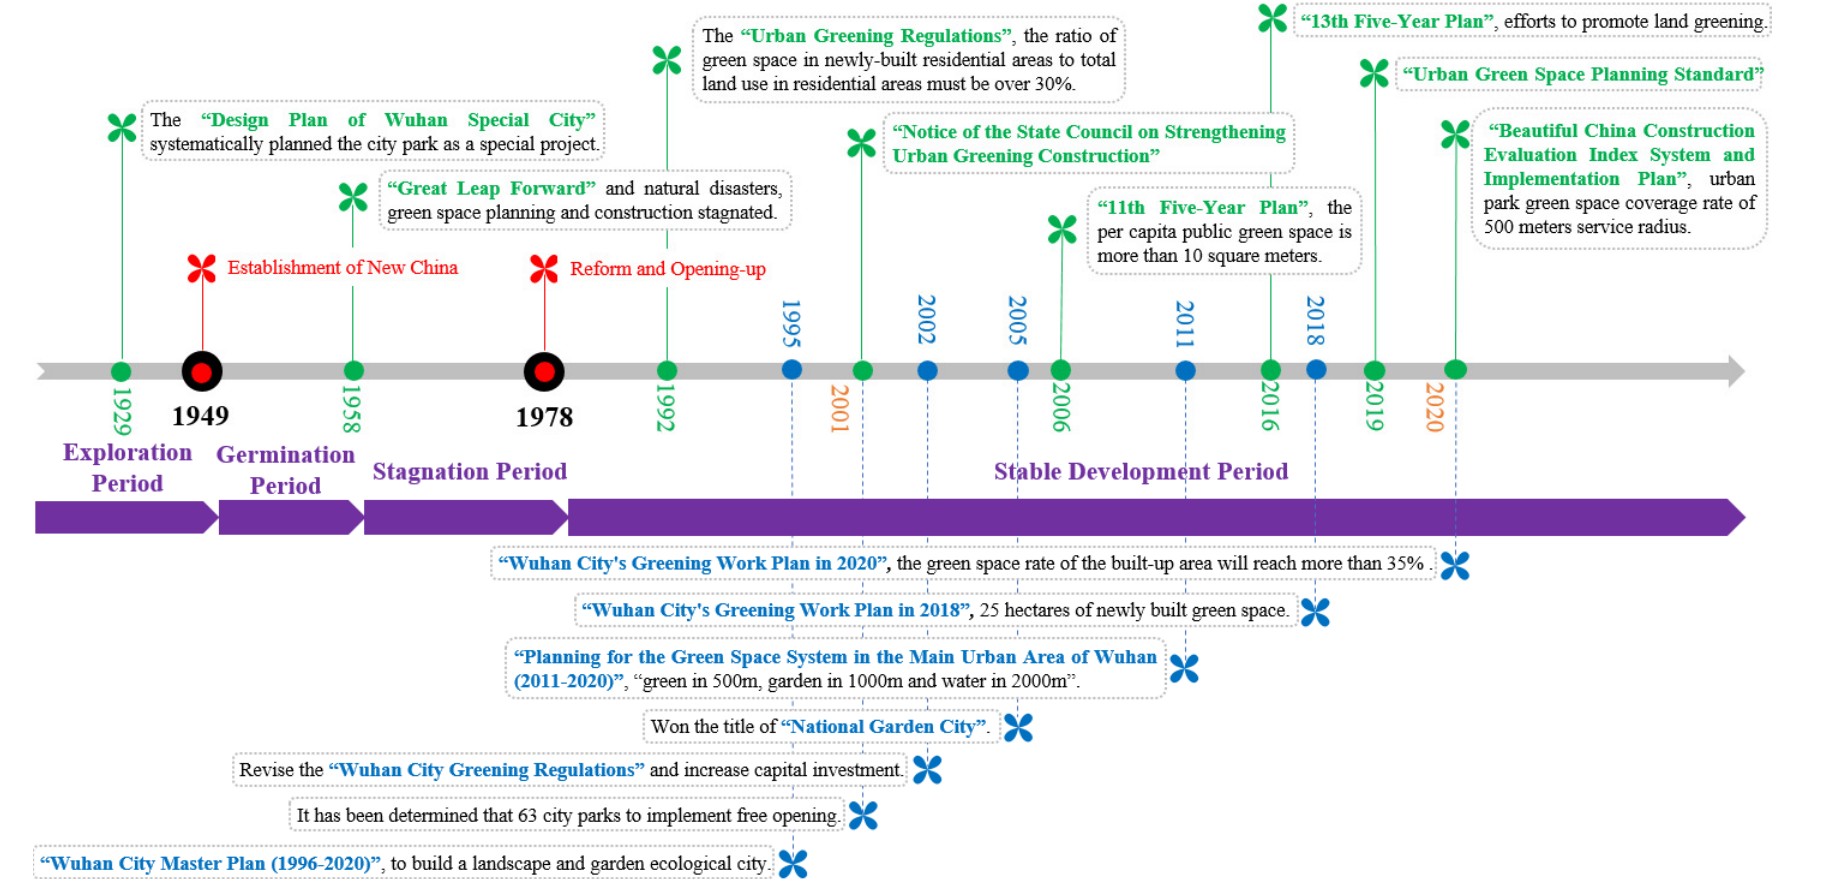
Figure 2. The development of park green space policy in China includes four stages: 1929–1949 exploration period, 1949–1958 germination period, 1958–1978 stagnation period and 1978–present stable development period.